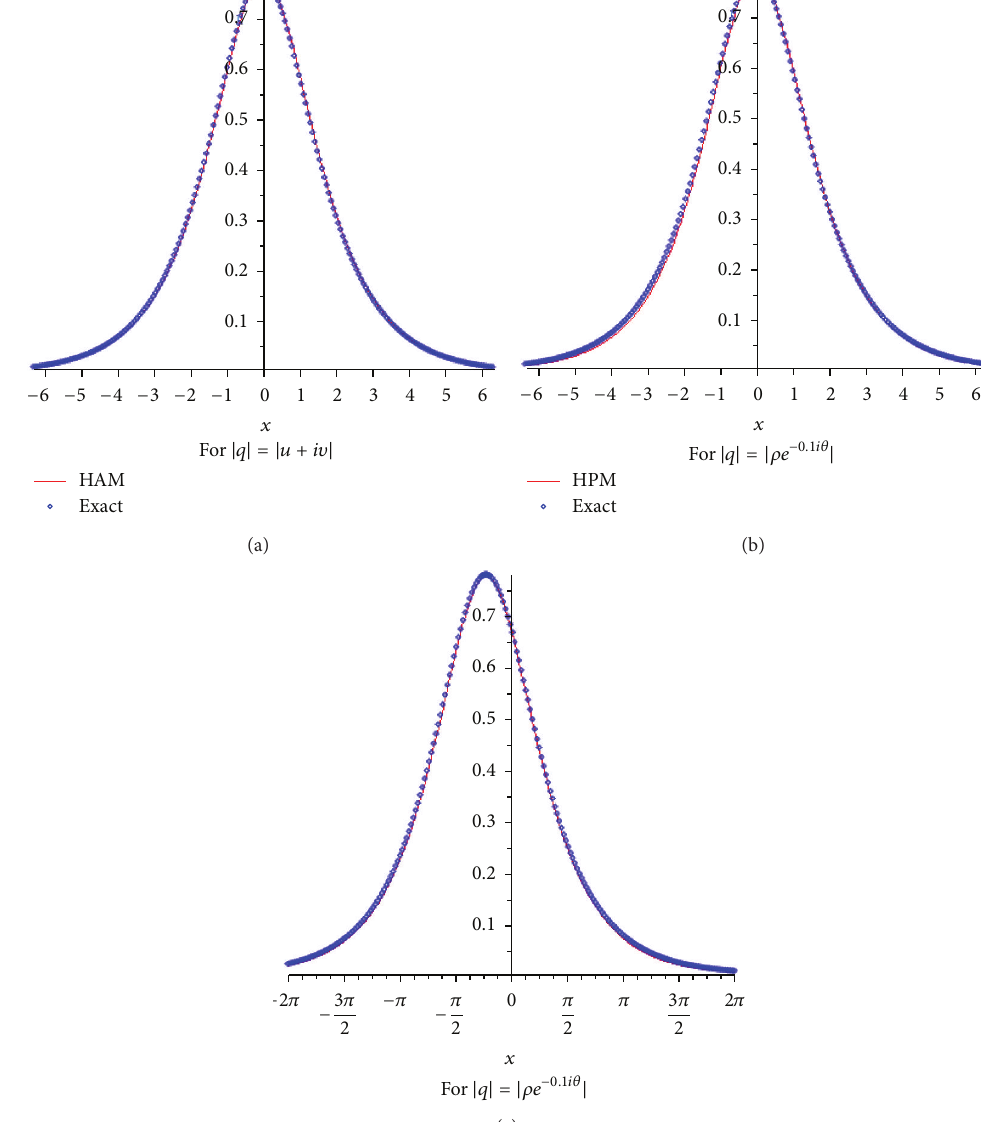
−𝑚 2 V V 2 ) 𝑝 3 + ⋅ ⋅ ⋅ , 1,2 2,0𝑦 + 𝜎 2 V − V 3,1𝑦𝑦 3,0𝑦𝑦 3,0𝑥𝑥